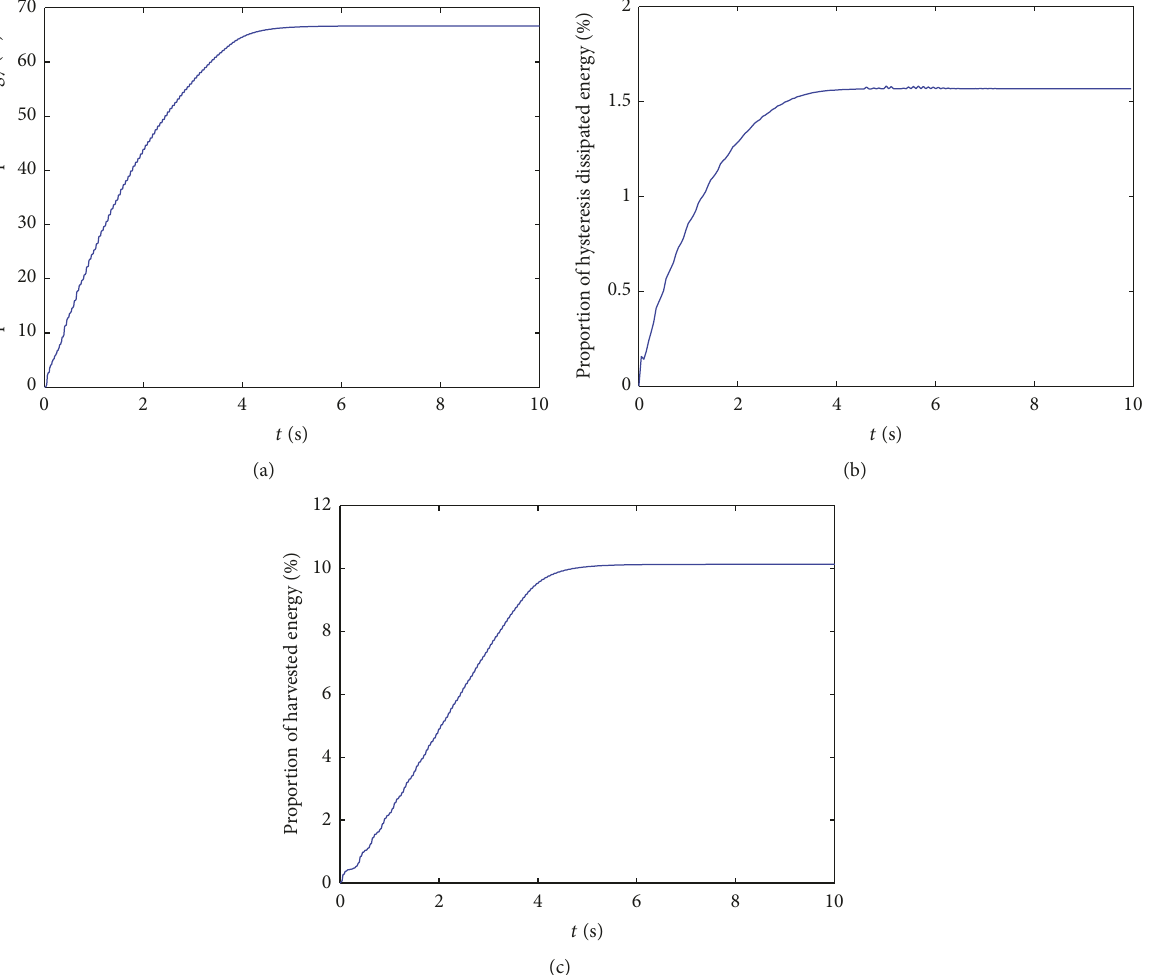
Figure 4: Configuration 1: (a) the percentage of energy dissipated by the NES damper; (b) the percentage of energy dissipated by the hysteresis behavior; (c) the percentage of energy harvested by the piezoelectric